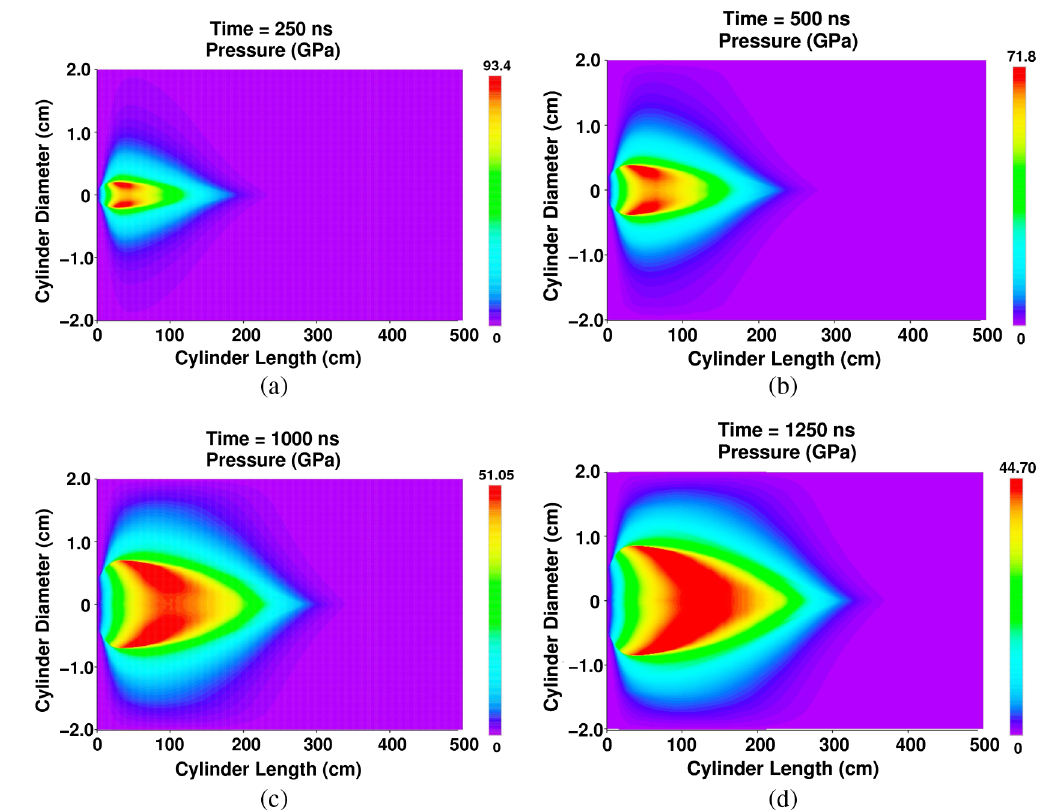
FIG. 7. Target pressure distribution calculated by BIG 2 (a) at t ¼ 250 ns (10 bunches delivered), (b) at t ¼ 500 ns (20 bunches delivered), (c) at t ¼ 1000 ns (40 bunches delivered), and (d) at t ¼ 1250 ns (50 bunches